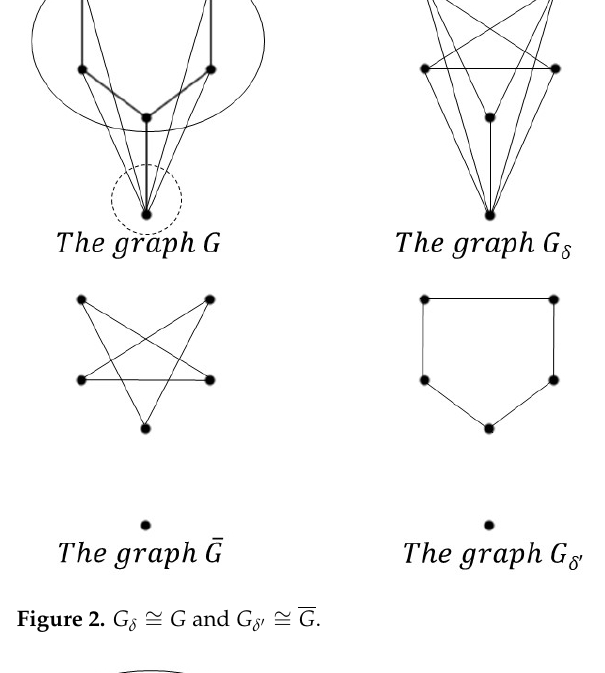
Figure 2. G δ ∼ = G and G δ (cid:48) ∼ = G .